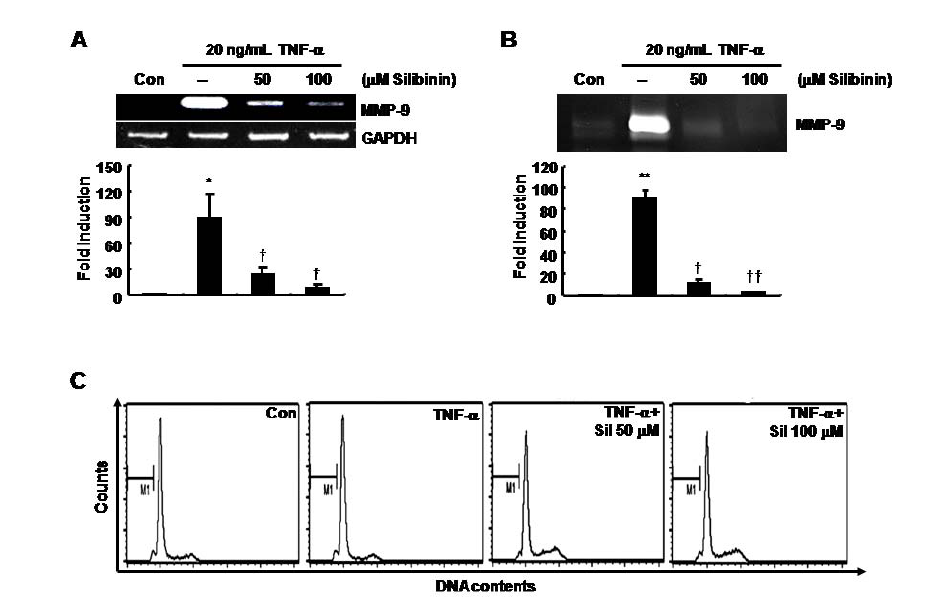
Figure 2. TNF- α -induced MMP-9 mRNA and protein expression was decreased by silibinin in a dose-dependent manner in SNU216 gastric cancer cells. After serum- starvation for 24 h, cells were pretreated with silibinin at the concentrations indicated for 60 min, and then treated with 20 μ g/mL of TNF- α for 24 h. MMP-9 mRNA and protein expression were analyzed by RT-PCR (A) and zymography (B), respectively. (C) Under the same conditions, the cell cycle was analyzed by FACS analysis, as described in the Materials and Methods. These results are representative of three independent experiments. The values shown are the mean ± SEM. * P < 0.05, ** P < 0.01 vs . control, † P < 0.05,